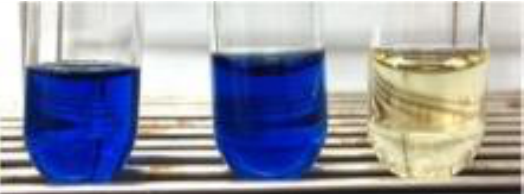
Figure 5. Decolorization of indigo carmine by the IOX/iodide system. The reaction mixture contained 10 mU mL −1 of IOX, 0.3 mM indigo carmine, 0.1 mM iodide, and 20 mM sodium acetate buffer (pH 5.5). The reaction time was 5 h. The left and middle tubes are negative controls in which IOX and iodide were omitted from the reaction mixture, respectively.